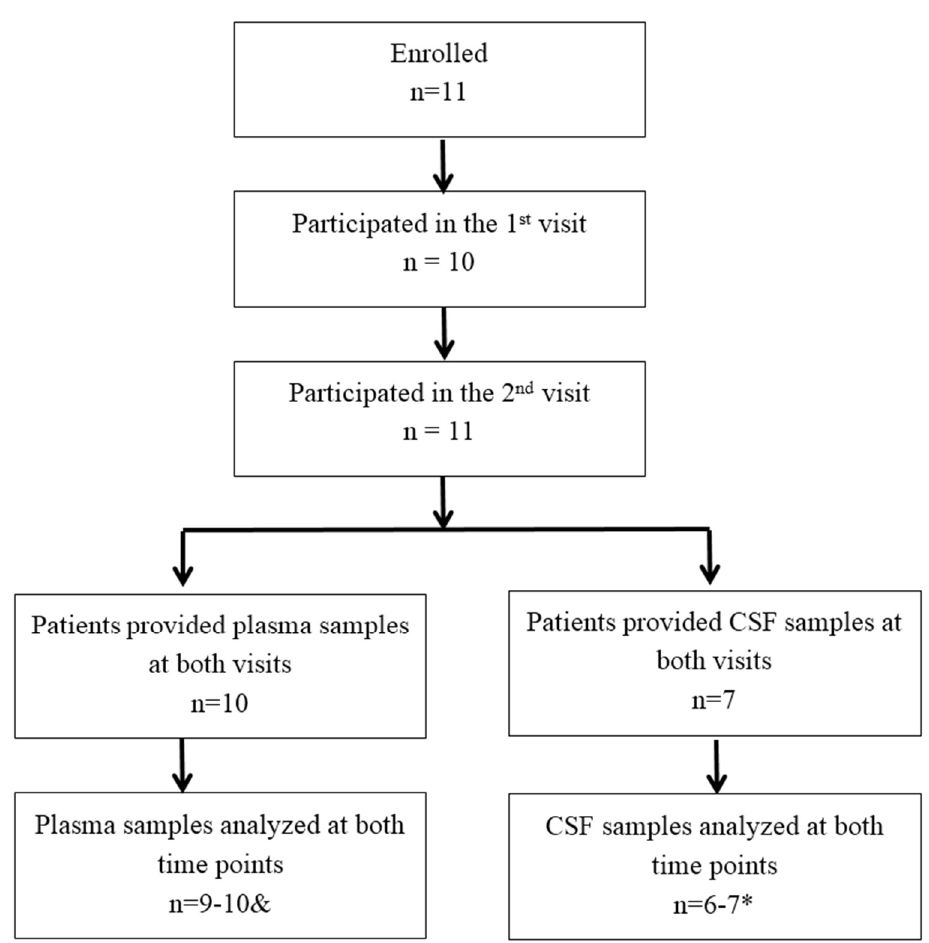
Figure 1. Flowchart of study population. *, & due to the amount of CSF samples available for analysis, seven pairs of CSF samples were analyzed for cGP and six pairs for IGF-1 and IGFBP-3. The data from one participant were excluded from statistical analysis due to a 15 times increase in CSF cGP and 19 times increase in plasma cGP after supplementation.